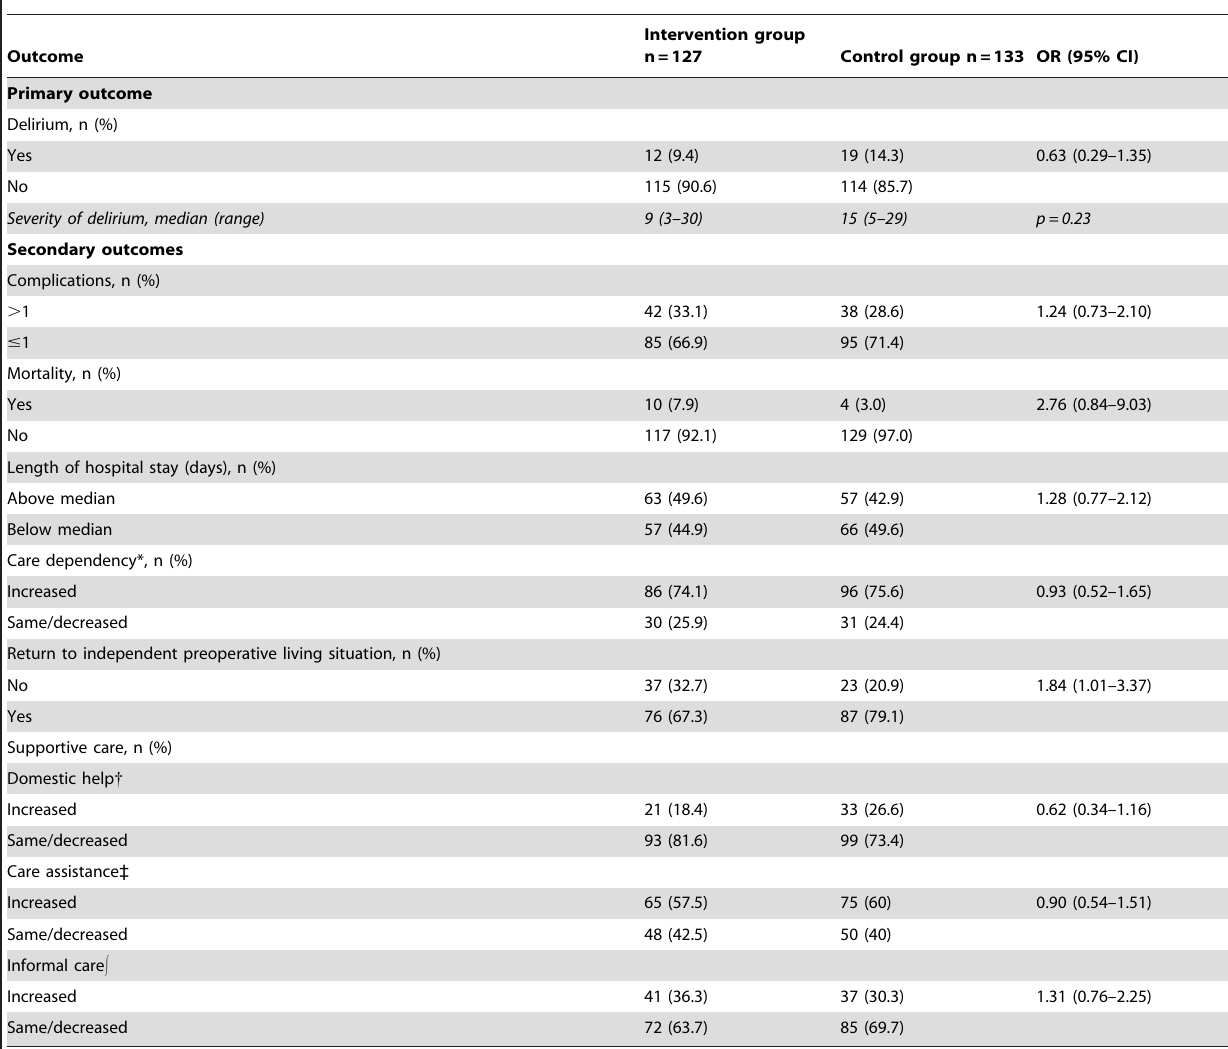
Table 4. Logistic regression analyses (intervention group versus control